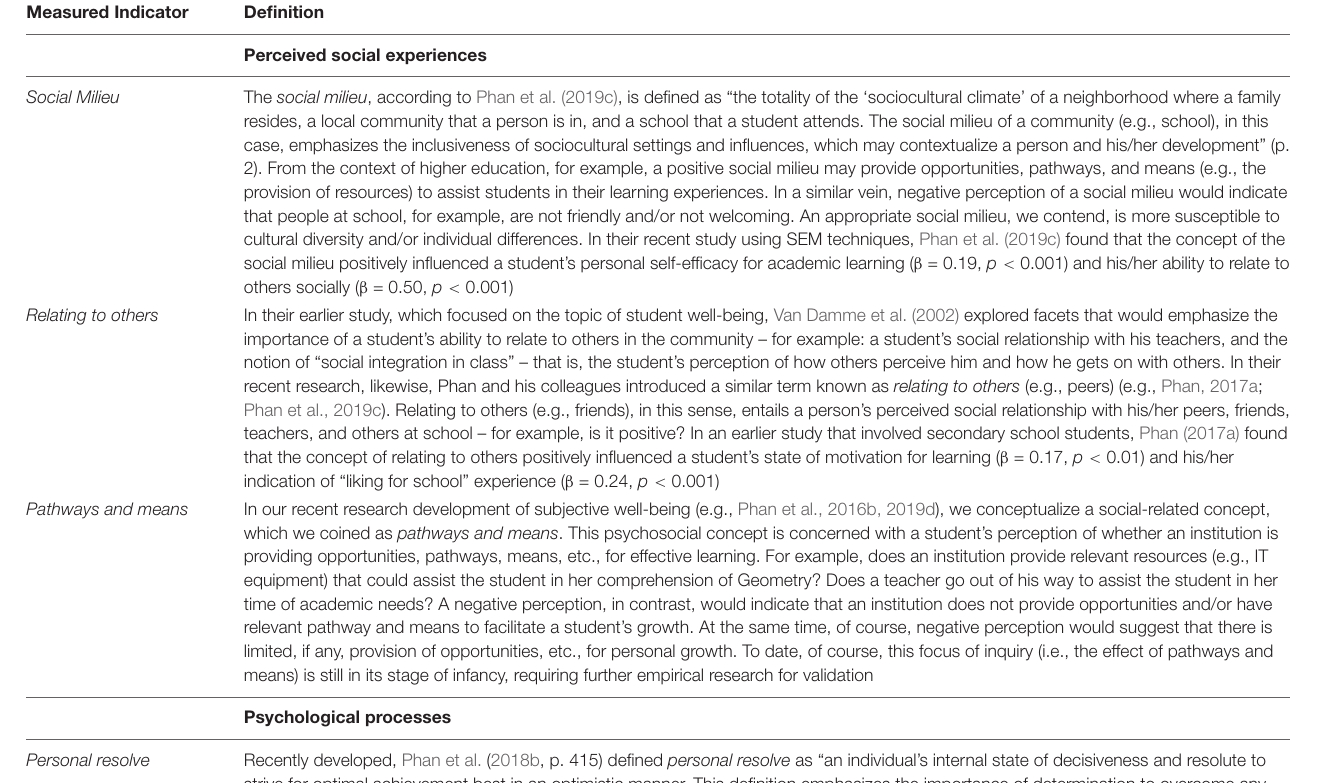
TABLE 1 | A summary of